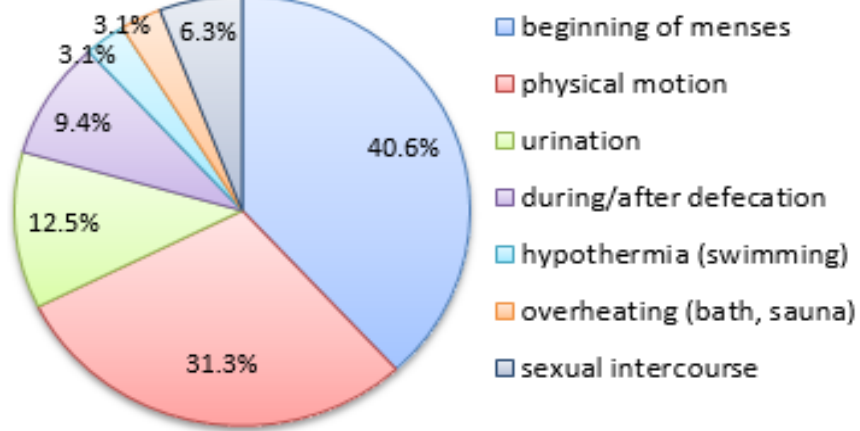
Figure 4. The factors of pelvic pain worsening in the study’s sample. Of note, 62.5% (20/32) of the patients reported having female relatives (mothers, sis- ters, aunts, maternal/paternal grandmothers) with a history of EMS or abnormal uterine